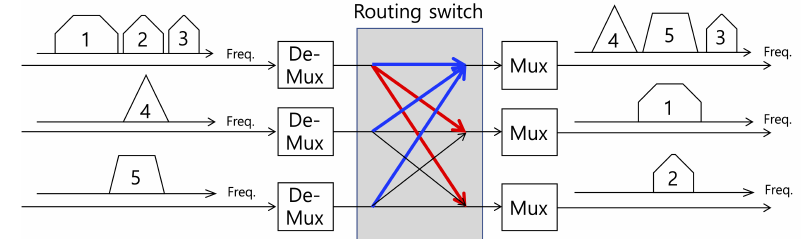
Figure 3. Functional block diagram and operational example of digital